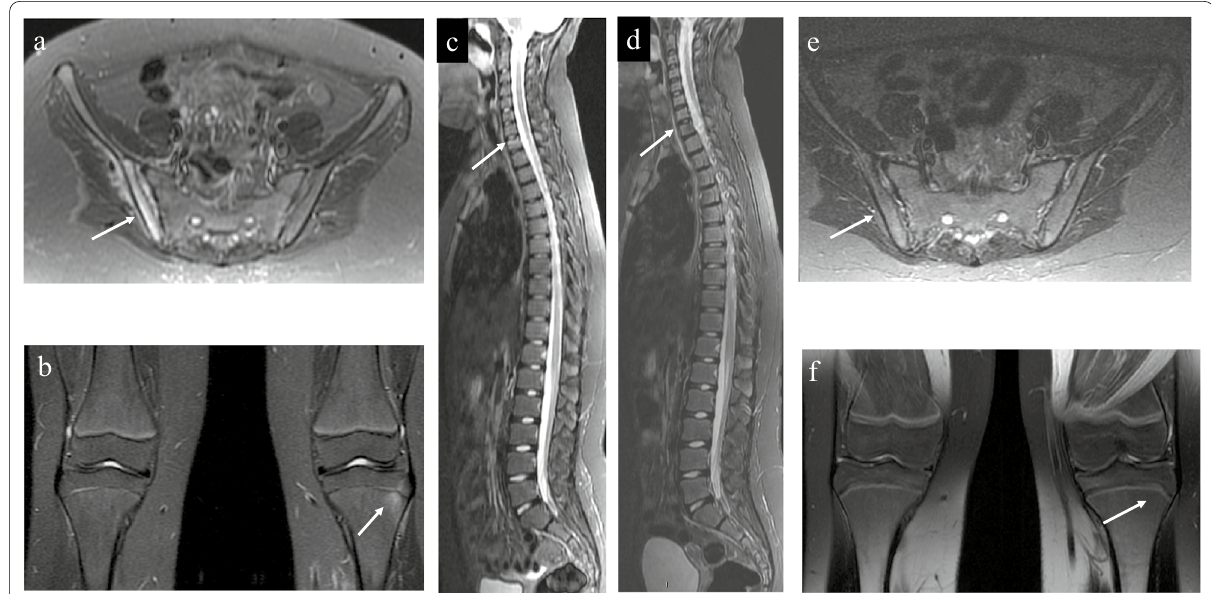
Fig. 13 A 10-year-old girl complaining of thoracic and lumbar pain for two years who was initially treated for Langerhans cell histocytosis, despite two negative biopsies, without resolution of the pain. A WB-MRI was performed, showing bone marrow edema in the iliac portion of the right sacroiliac joint with joint effusion ( a ), lesion in the left proximal tibial metaphysis extending to the epiphysis ( b ) and edema and height loss of the vertebral body of T1 ( c ). The patient started treatment for CNO with non-steroidal anti-inflammatory drugs (NSAIDs) and pamidronate and showed clinical improvement. WB-MRI performed after 3 months showed stability of the T1 fracture ( d ) and complete resolution of the lesions of the pelvis ( e ) and the knee ( f ), without the appearance of new lesions